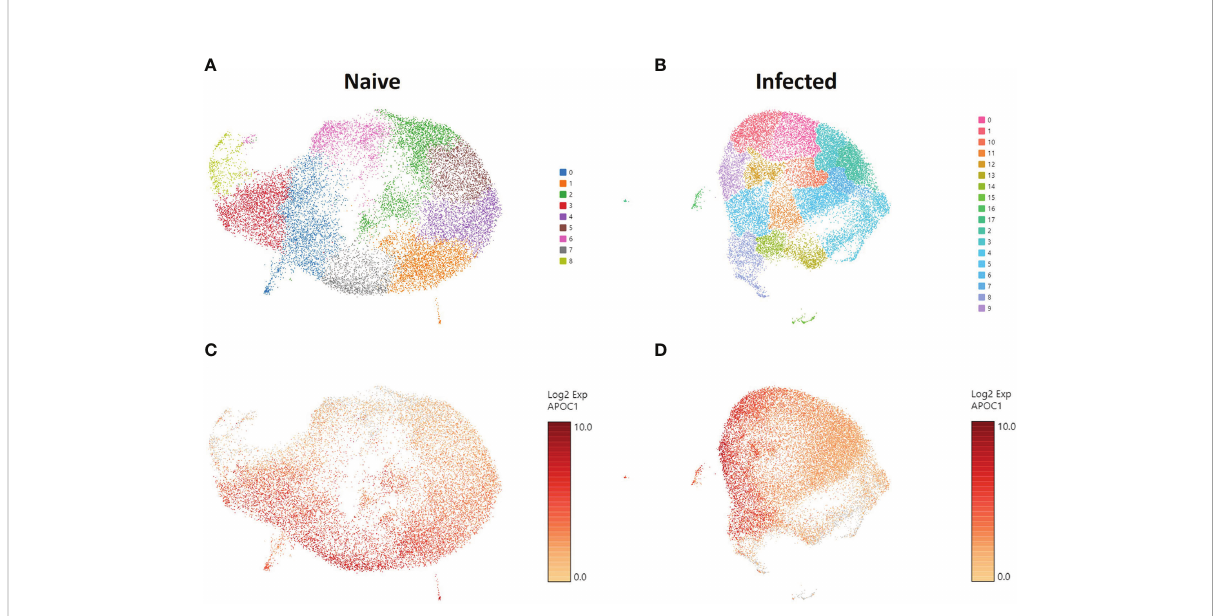
FIGURE 3 Phagocytic APCs Incubated with and without C neoformans Show Distinct Clustering of Cells which Are Not Correlated with Macrophage Identity. Processed human BAL cells were enriched for phagocytic APCs and incubated with or without C neoformans strain H99 for 2h and then processed for scRNA-seq. scRNA-seq analysis identi fi ed 9 and 18 discrete clusters among the naïve (A) and infected (B) cohorts, respectively. Cells were also examined for the expression and distribution of APOC1 (macrophage gene) for both naïve (C) and infected (D) cohorts. The distribution of macrophages did not follow the clustering scheme for either of the cohorts. Data shown are transcriptional regulation of shown genes for 18,958 (naïve) and 22,344 (infected) total cells for three individual experiments for each cohort